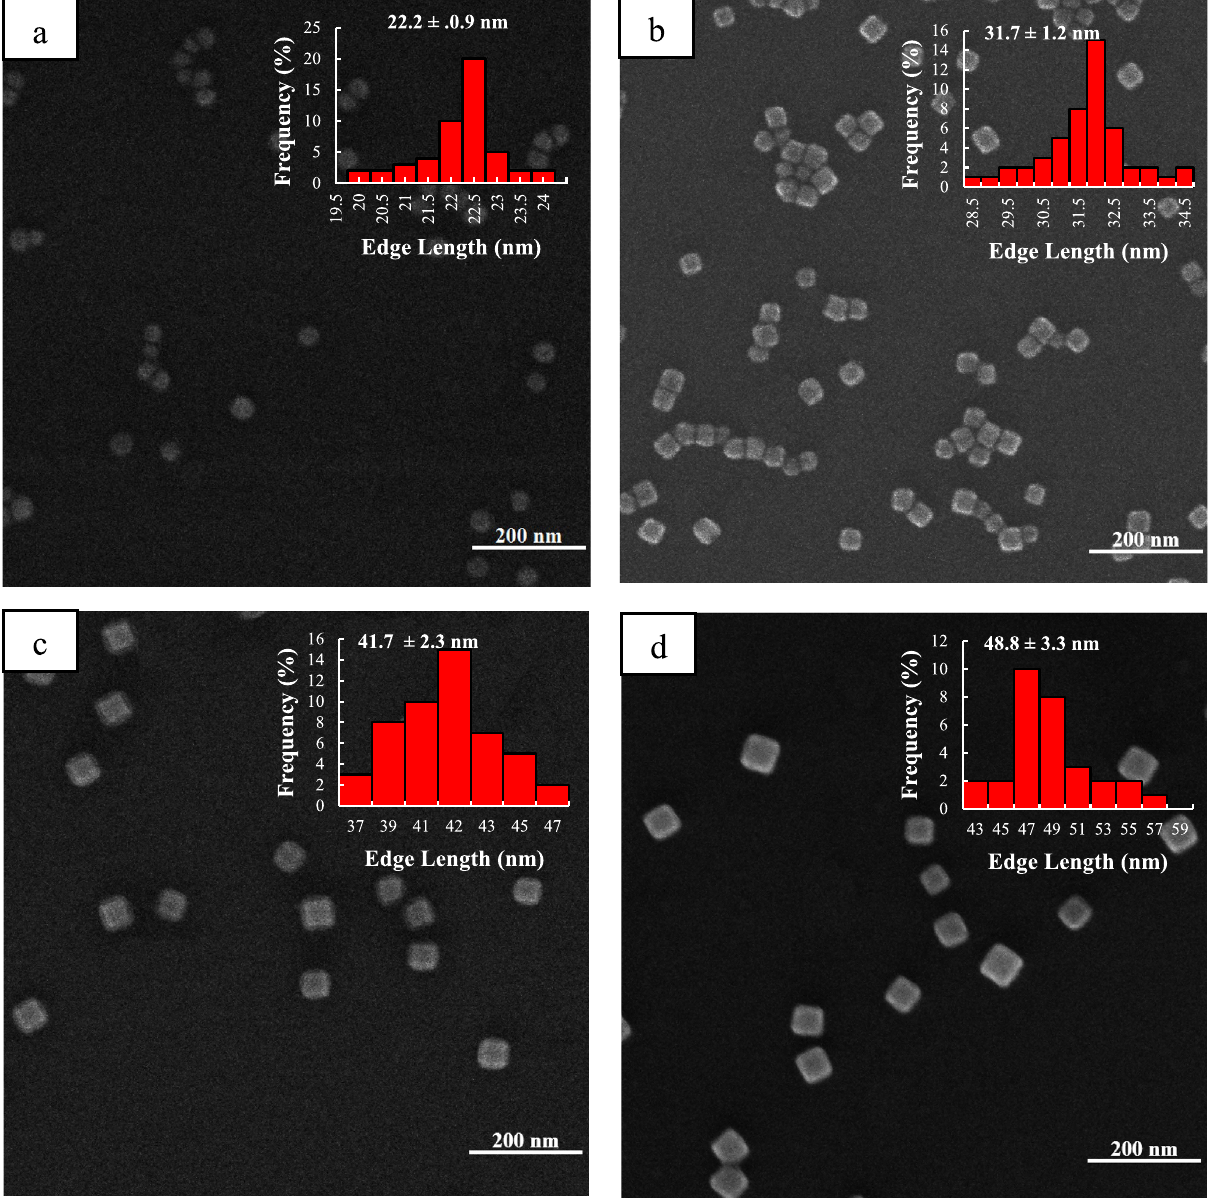
Figure 2. SEM images of Ag nanocubes obtained under dark conditions at different reaction times: ( a ) 15, ( b ) 30, ( c ) 60, and ( d ) 90 min. The insets show the size distribution of the Ag